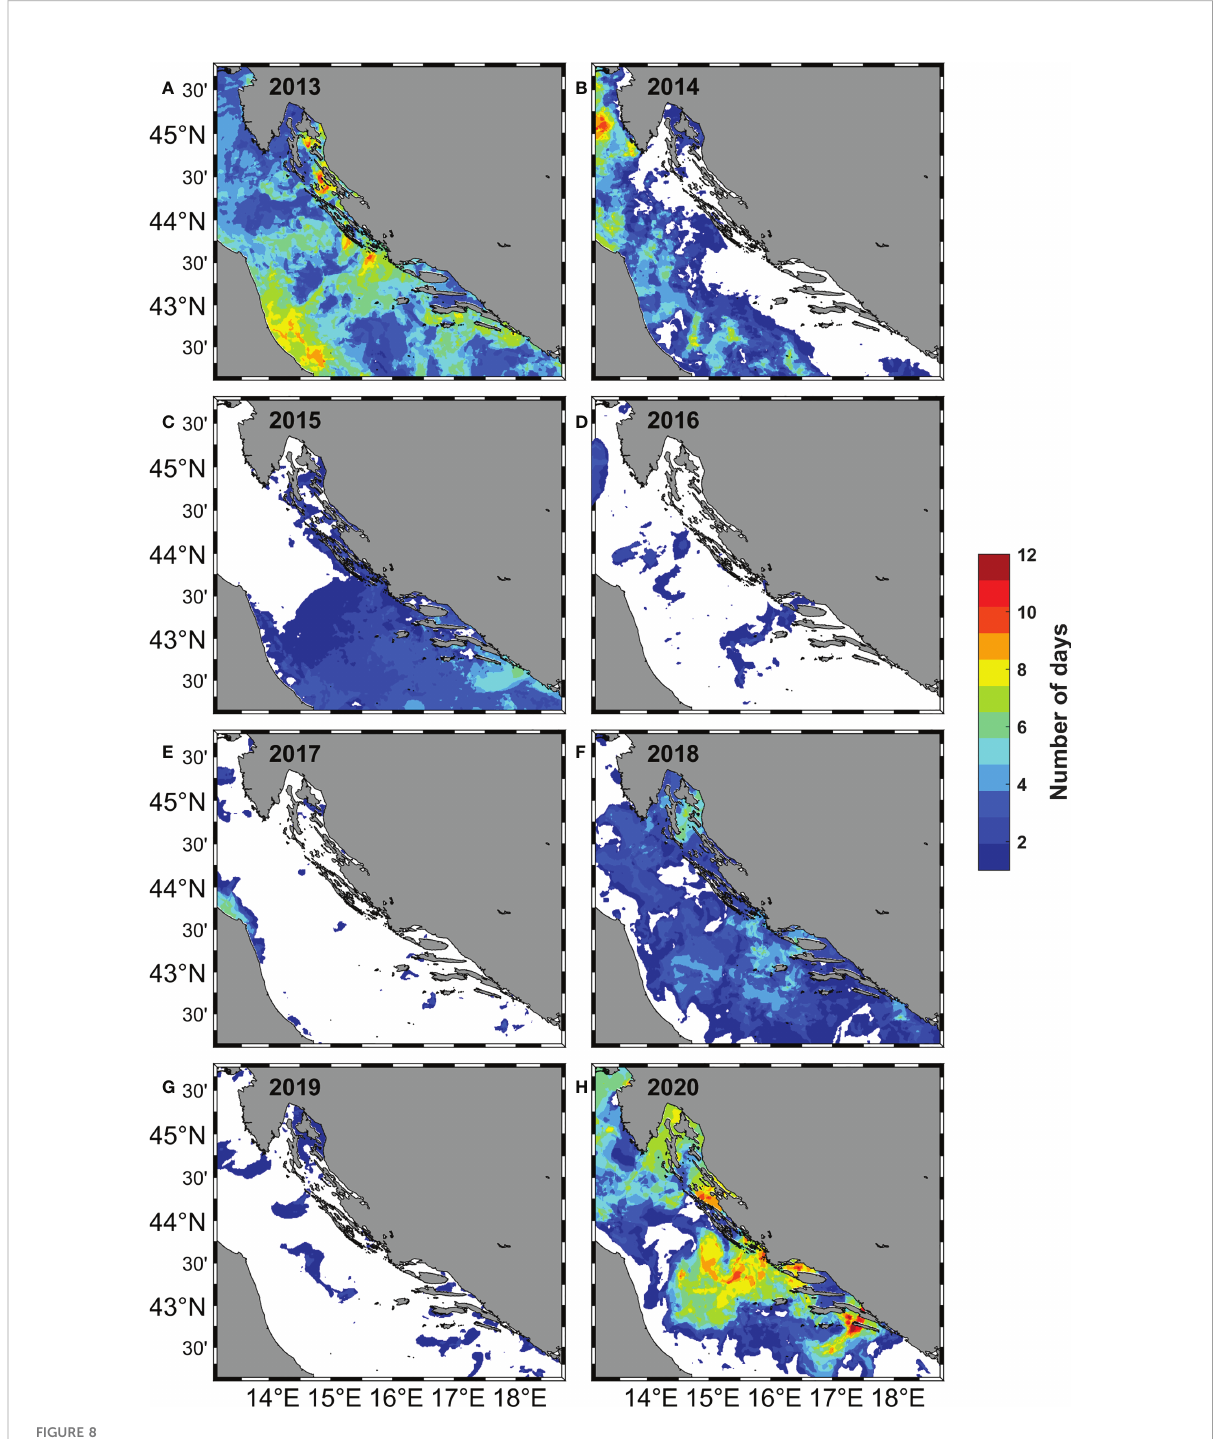
FIGURE 8 Number of days for the month of July in 2013 - 2020 (A – H) when upwelling occurred, was determined using the upwelling detection method based on SST